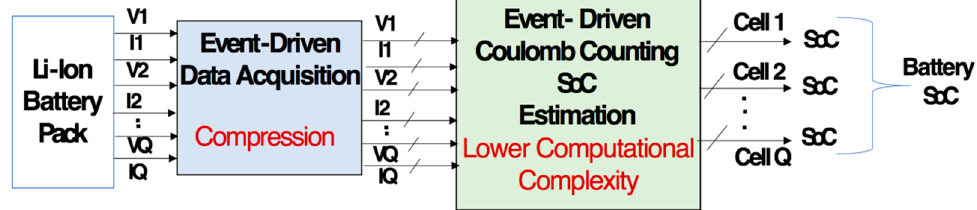
Figure 1. The system block diagram.